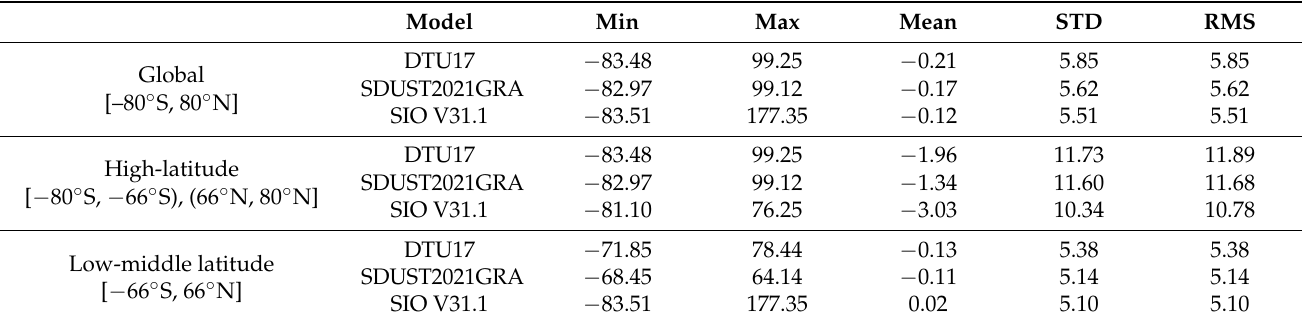
Table 2. The difference between global gravity anomaly models and shipboard gravity anomalies in different regions (Unit: mGal).